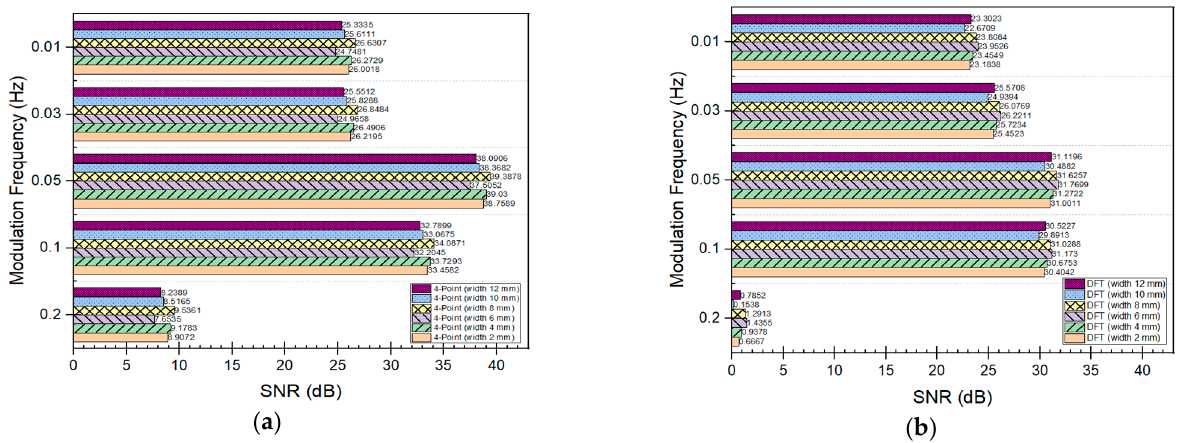
Figure 16. SNR value according to different defect width in sample group 3: ( a ) HA, ( b ) FFT.